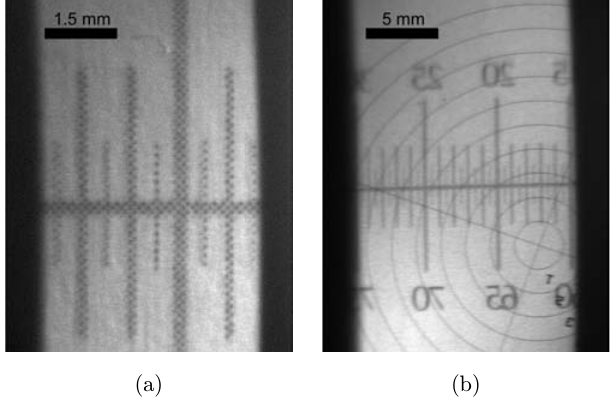
Fig. 5. Lateral FOV of (a) the classic 4F transmission VHI system and (b) the VHI system with demagni¯cation system. The test target is illuminated with a broadband light source (FWHM spectral bandwidth (cid:1) 34 nm). The lateral FOV is enlarged more than three times with the demagni¯cation